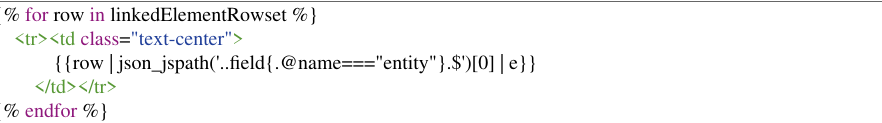
Fig. 8. AMI-Twig and JSPath in